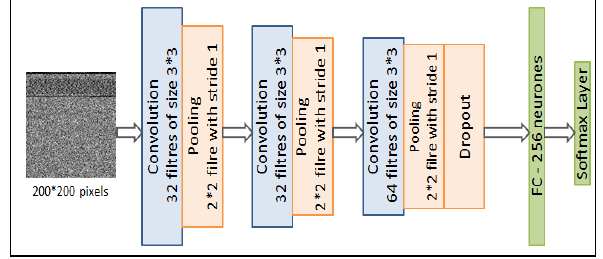
Figure 7. Our proposed CNN model for classification of malware represented as grayscale images.